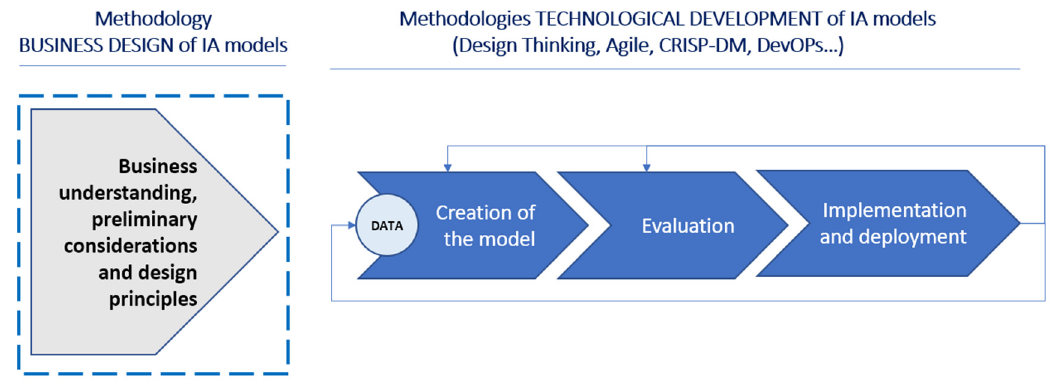
Figure 8. Detailed 360° approach to Model AI development . Source: own elaboration.